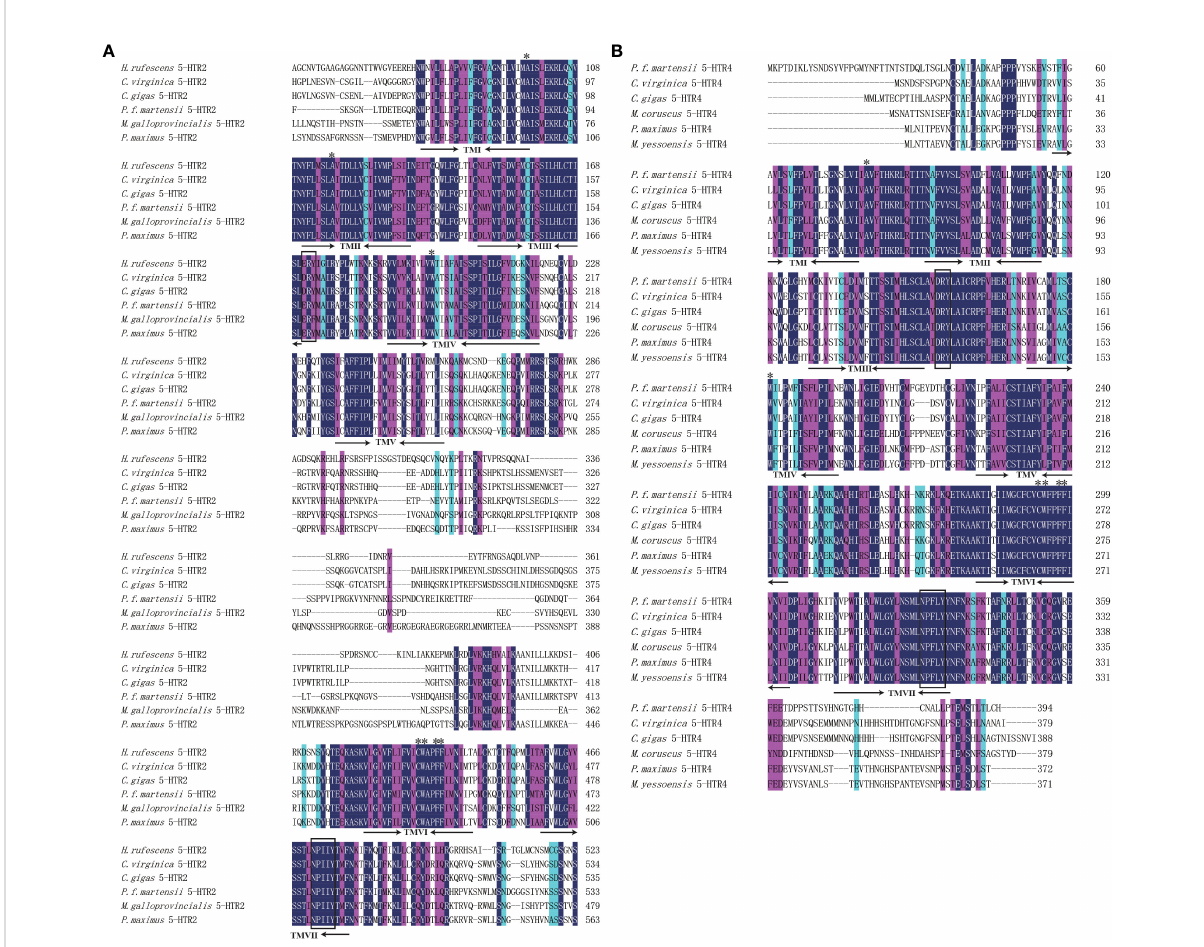
FIGURE 2 Multiple sequence alignment of Pm5-HTR2 (A) and Pm5-HTR4 (B) . The numbers on the right present the total amino acid of each protein. The conserved residues believed to be involved in 5-HT – receptor binding is indicated by asterisks. The rectangular box indicates the conserved residues of